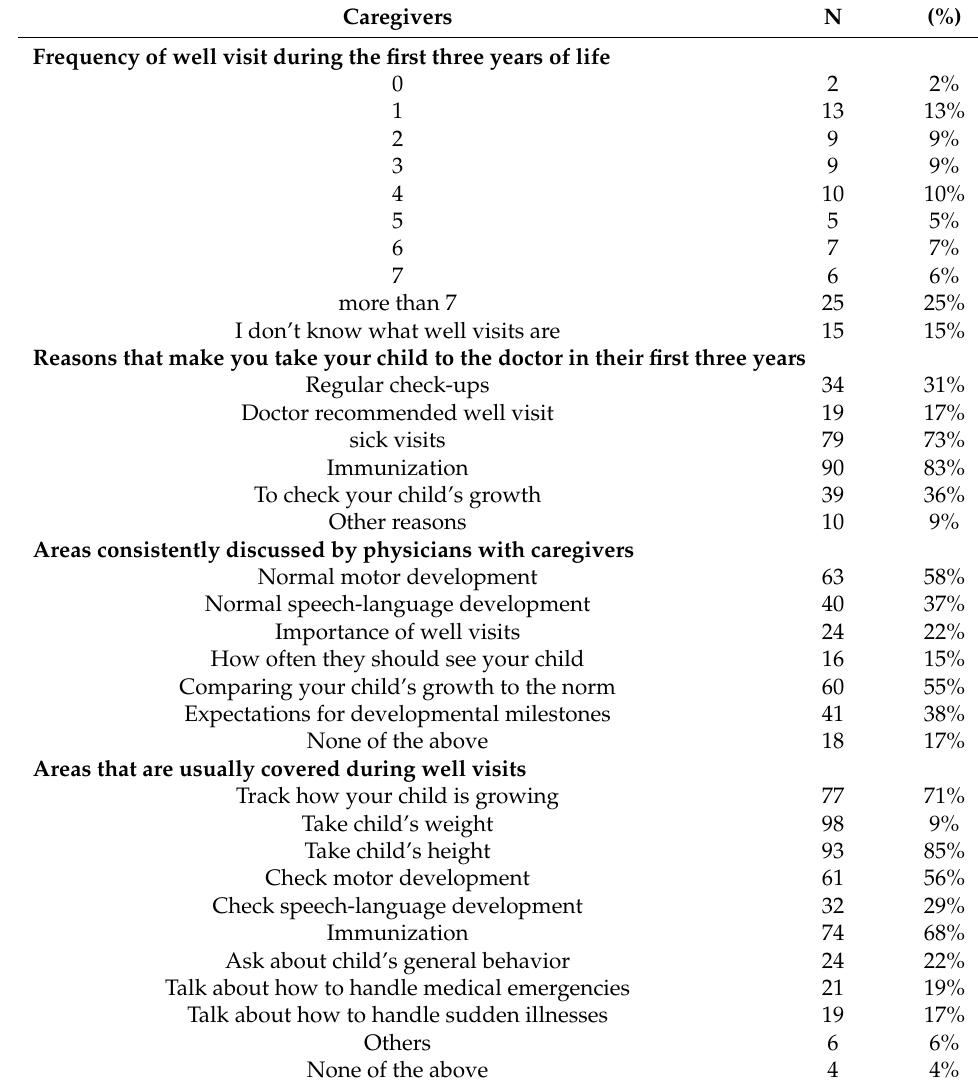
Table 3. Early Detection Practices from Caregivers’